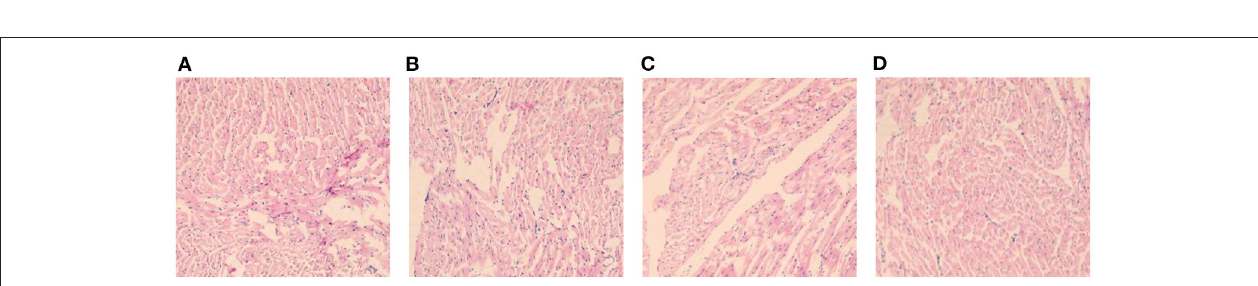
FIGURE 4 | Body weight, blood glucose and lipid levels of rats in each group (A) is the comparison of body weight of four groups of rats, (B) is the comparison of GLU level of four groups of rats, (C) is the comparison of TC level of four groups of rats, (D) is the comparison of TG level of four groups of rats. Compared with the DCM group, # P < 0.05; compared with the S1 group, * P < 0.05; compared with the S2 group, N P < 0.05.